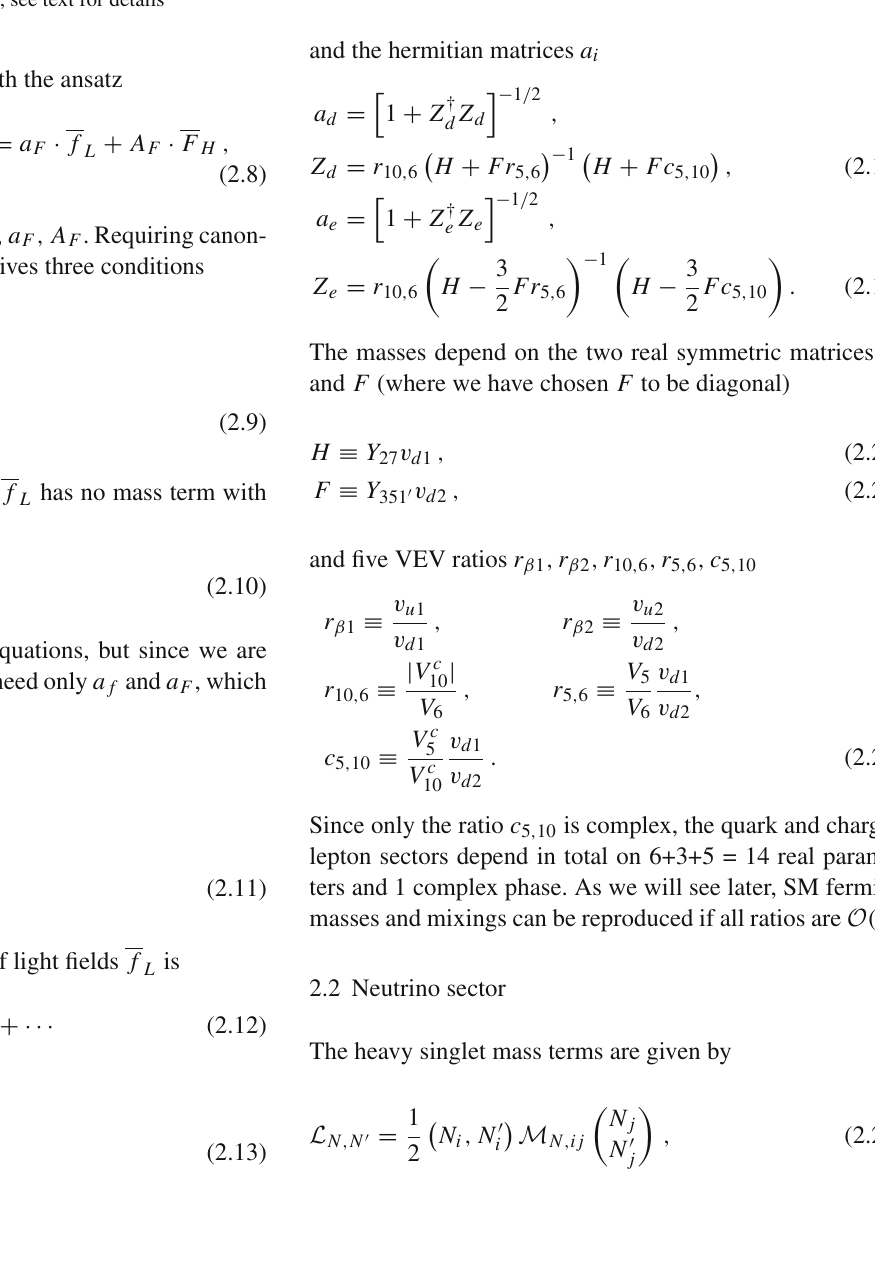
Fig. 1 Sketch of heavy particle scales, see text for